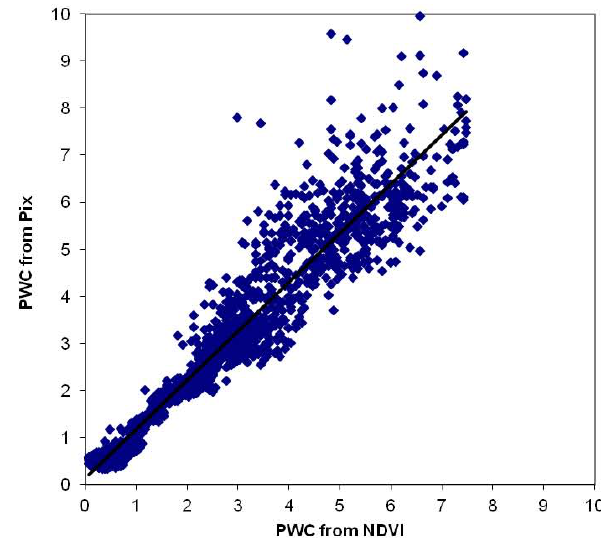
Fig. 1. Flowchart of the HydroAlgo algorithm for estimating both snow depth (SD) and soil moisture (SMC). Fig. 2. The Plant Water Content (PWC, in kgm